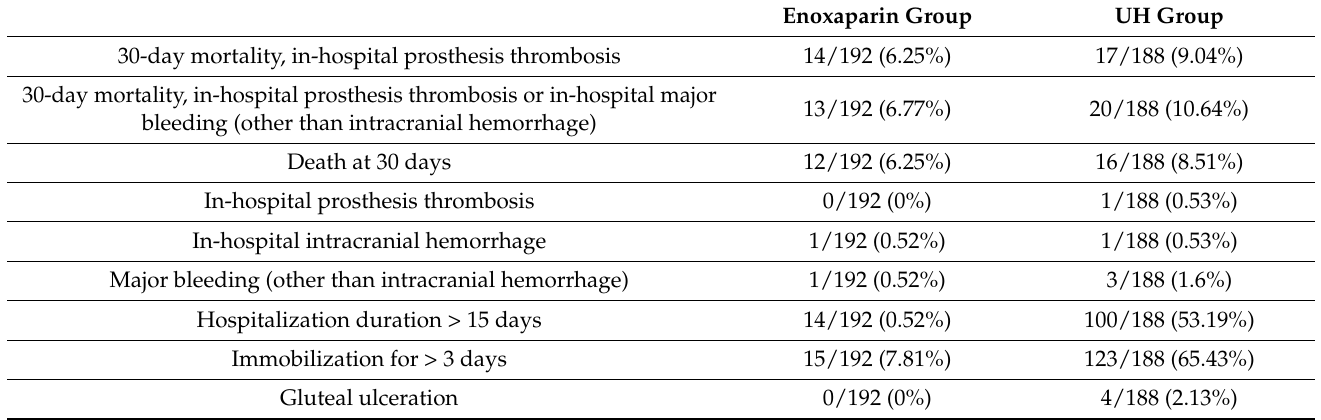
Table 4. Frequency of composite and single endpoints at hospital discharge and 30 days after dis ‐ charge.